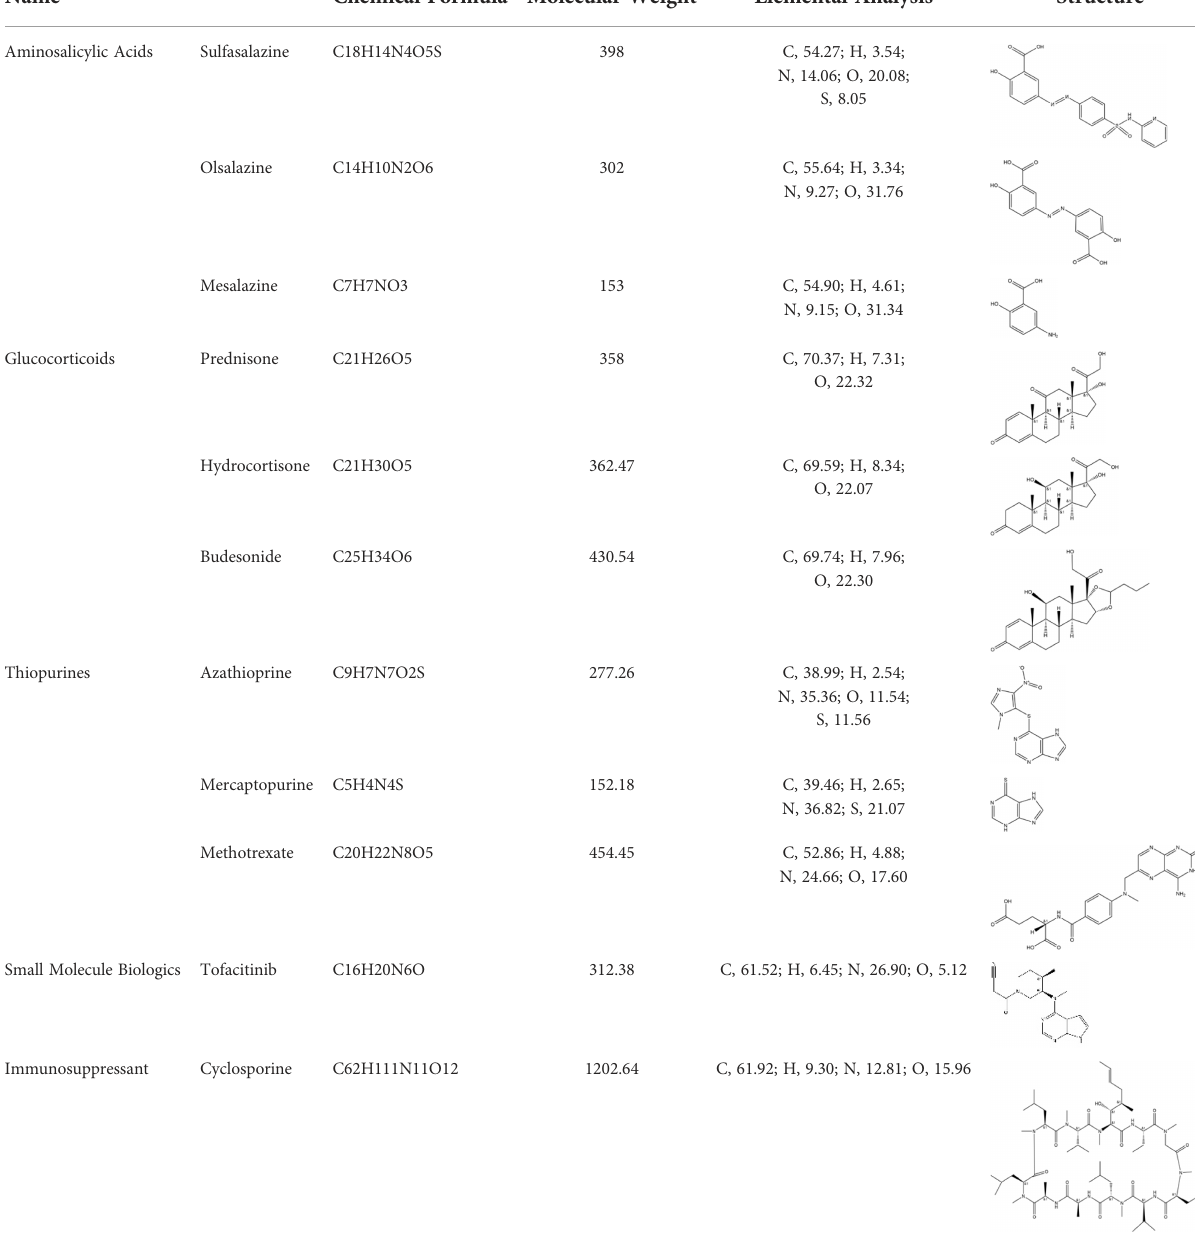
TABLE 1 Potent IBD drugs. Name Chemical Formula Molecular Weight Elemental Analysis